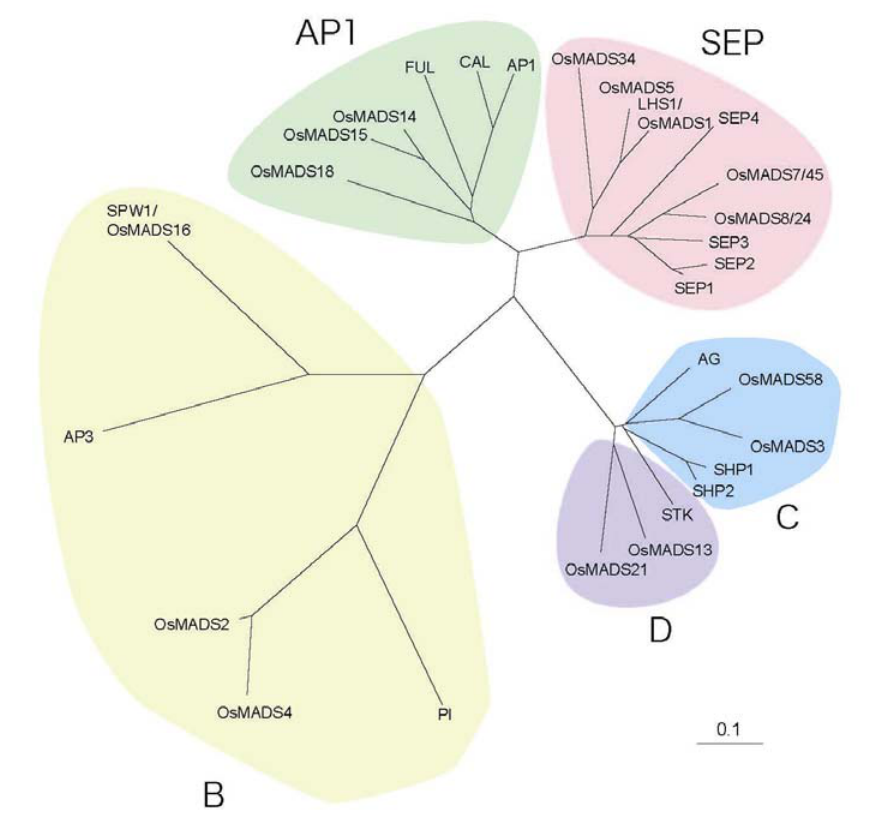
FIGURE 1. Phylogeny of the major classes of MADS-domain proteins from rice and